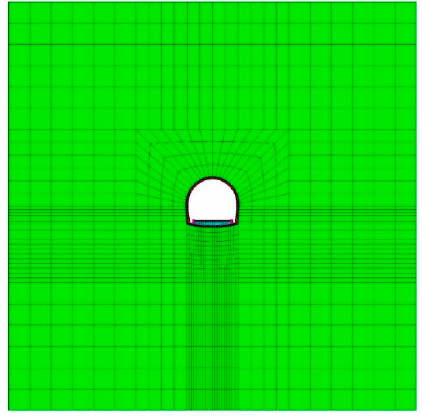
Figure 6. Numerical simulation